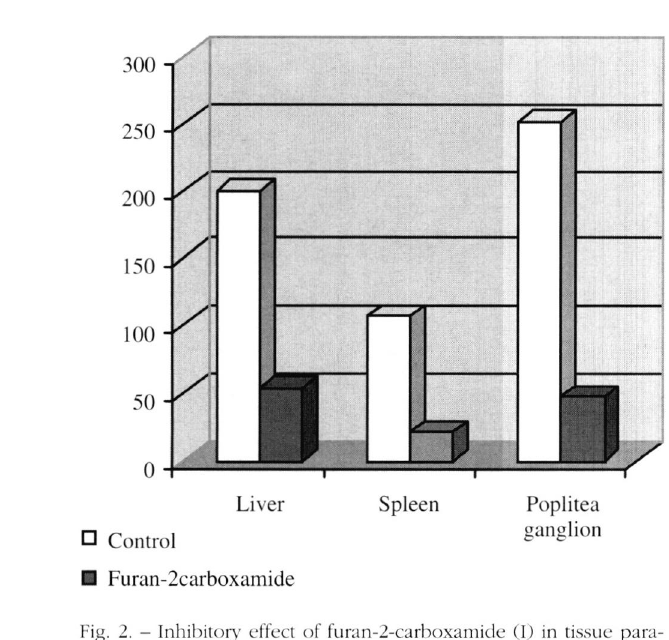
Fig. 2. - Inhibitory' effect of furan-2-carboxamide (I) in tissue para­ site burden in spleen smears (amast./500 fields), liver smears (amast. x 10 1 1 0 00 cells), and poplitea lymph node (amast./50 fields) after intraperitoneal administration of 10 mg/kg daily, during five conse­ cutive days to BALB/c mice randomly sorted into two groups of five animals. Values as means ± standard error.